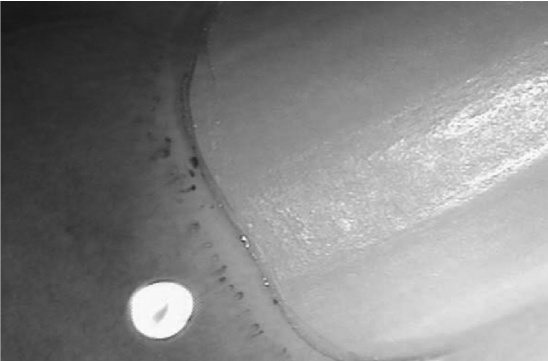
Fig.1. Microscopic image of nailfold of a scleroderma patient showing megacapillary (arrow) and irregular capillary orientation.